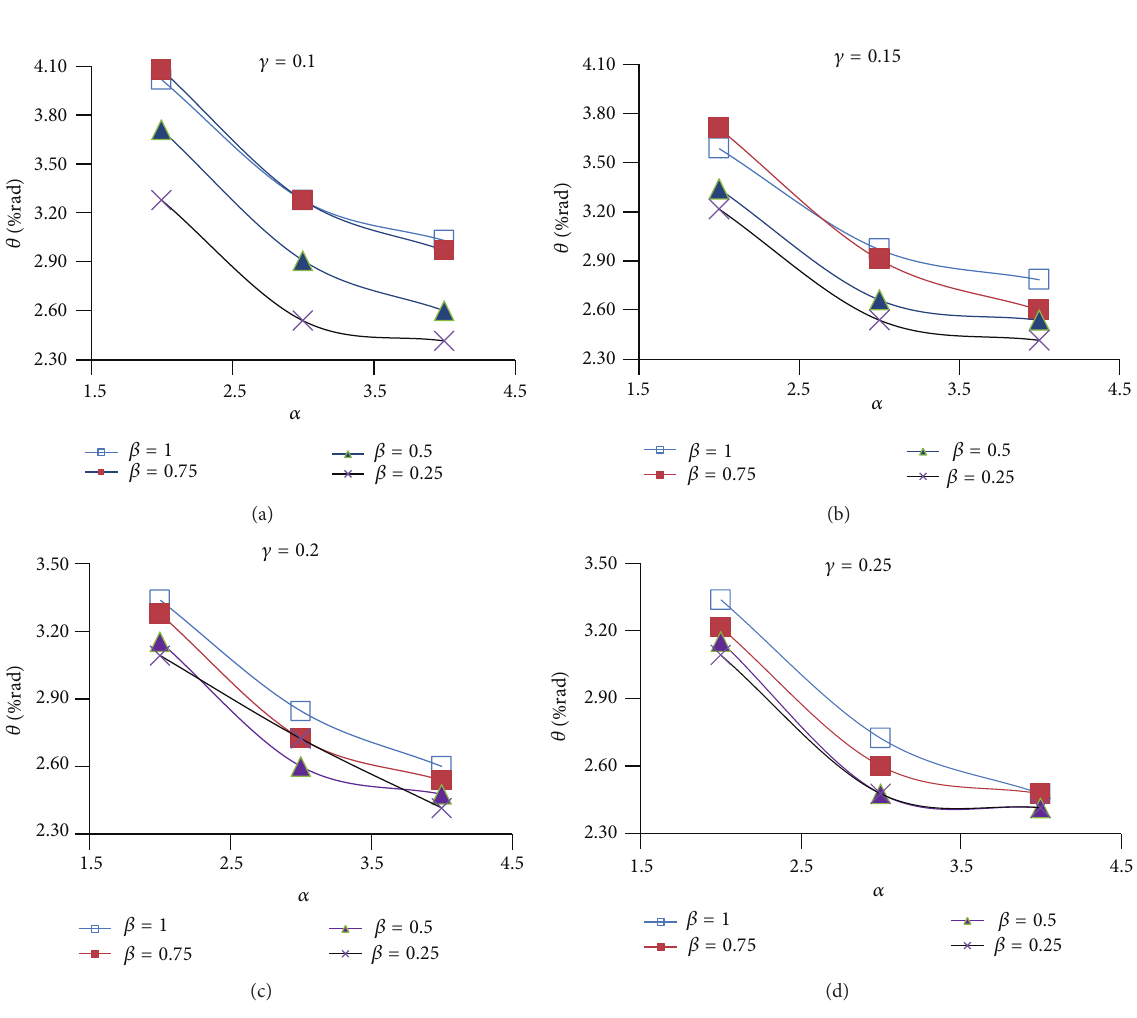
Figure 10: 𝜃 versus 𝛼 for different values of 𝛽 and 𝛾 for